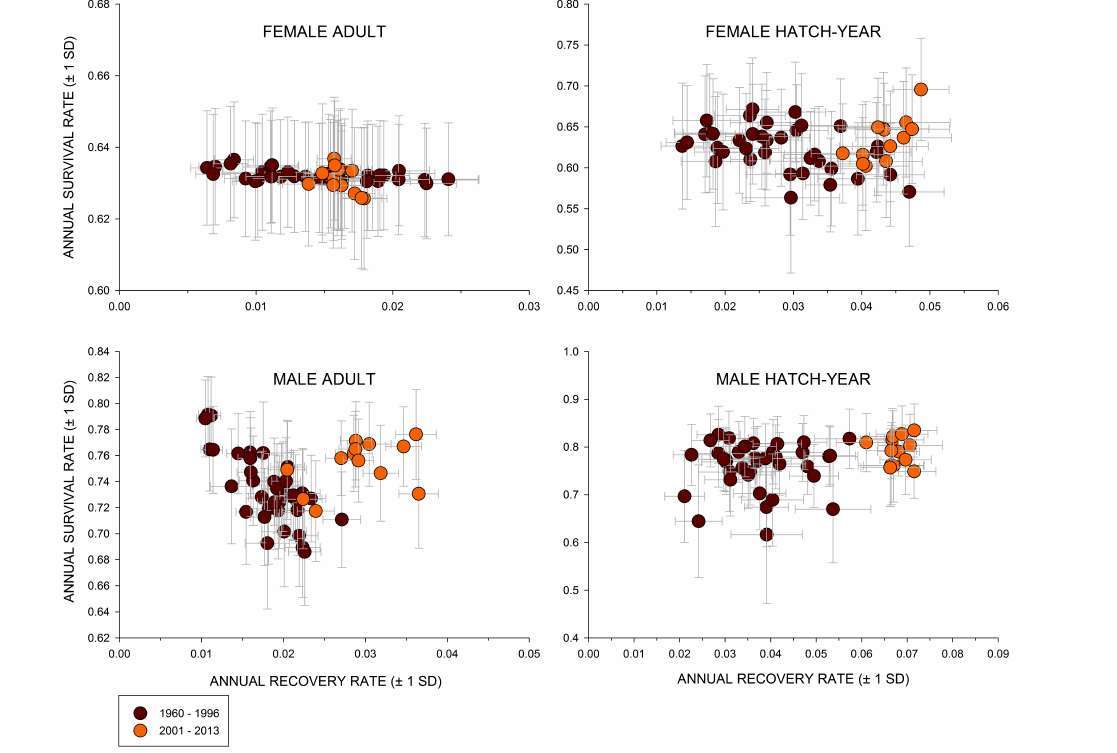
Fig. 9. Relationships between annual survival rates ( S ) and annual recovery rates ( f ) for Northern Pintail ( Anas acuta ) banded in southern Alberta and Saskatchewan, Canada (≤ 54° N latitude) from 1960–1996 and 2001–2013. Rates were derived from the model S chain Monte Carlo method.